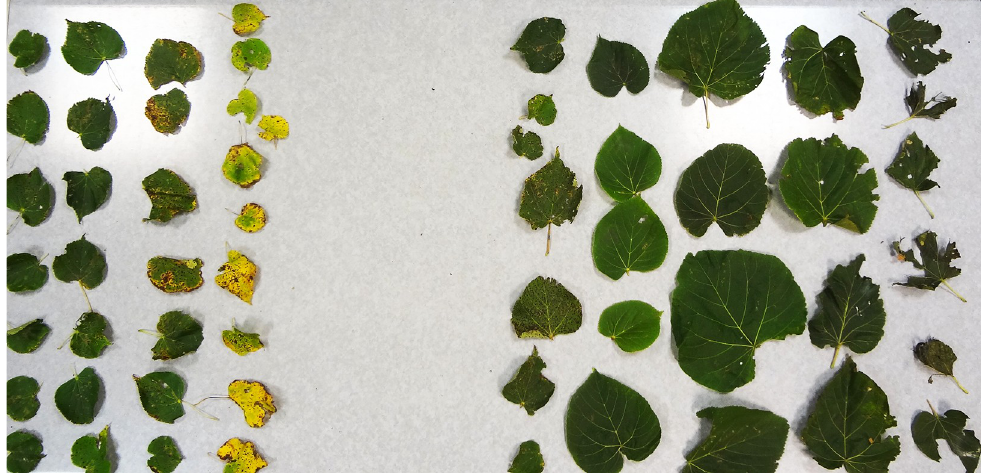
Fig 6. Leaves collected from CT, on the left, leaves from PT from within the offshoots’ zone, on the right, September 30, 2016. Photo by M.